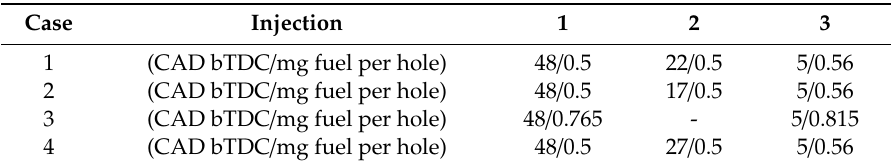
Table 1. Simulated case. Case 1 corresponds to the experimental case, whereas the cases 2–4 are performed to investigate the e ff ect of injection strategies on the partially premixed combustion (PPC) engine performance. CAD: crank-angle degree; bTDC: before top-dead-center.